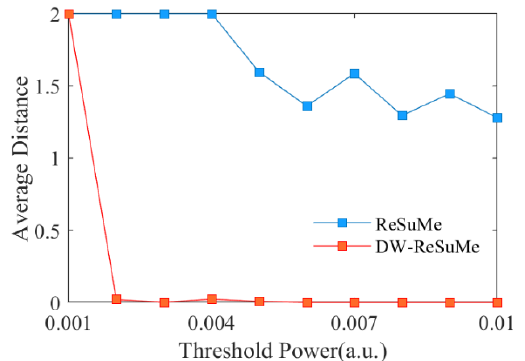
Figure 11. The average distance from epoch 101 to epoch 300 as a function of threshold power with the two learning algorithms. two learning algorithms.